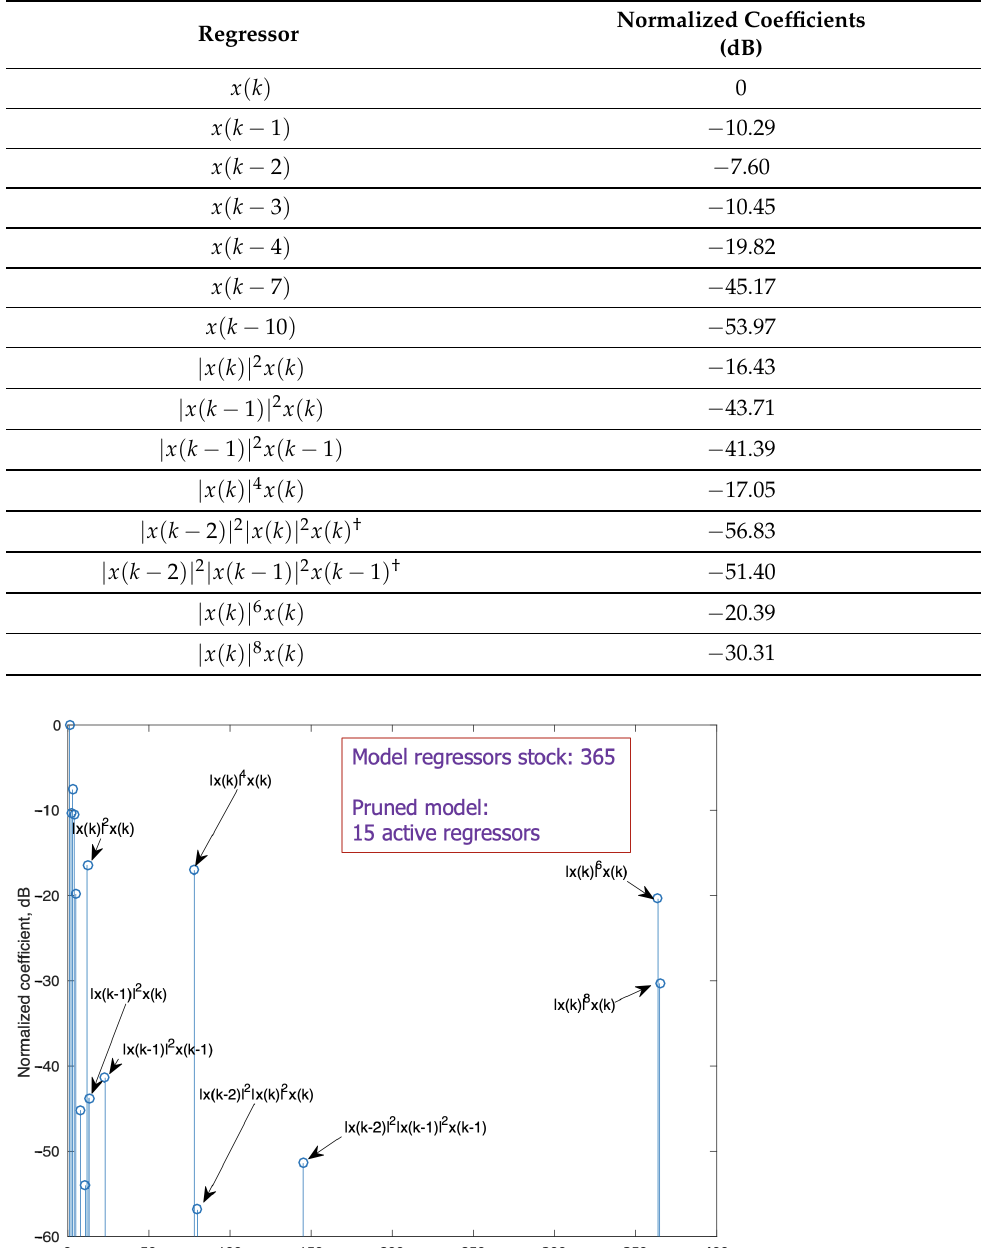
Table 1. Identified regressors. Input signal: 30 MHz 5G-NR and P out = 27.6 dBm.